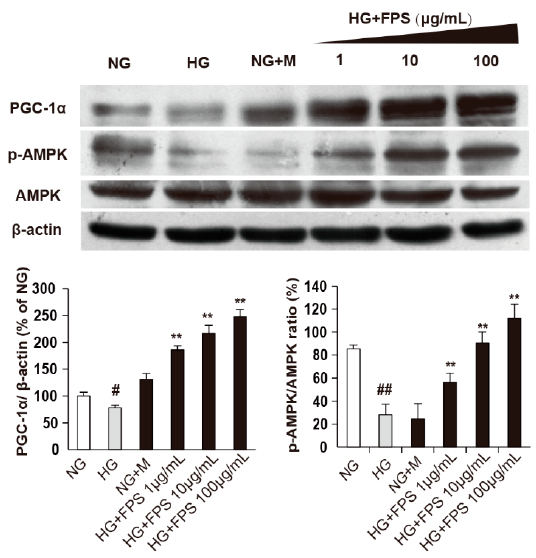
Figure 9. The effects of FPS on expression of AMPK and PGC-1 α : ( A ) The protein expression was assayed by Western blotting; ( B ) The quantized data of protein were expressed by mean ± S.D. ( n = 3). ## or ** p < 0.01; #, p < 0.05; “#”or “##”, HG vs. NG; “**”, HG vs. HG + FPS. The ordinate is a percentage relative to NG group.